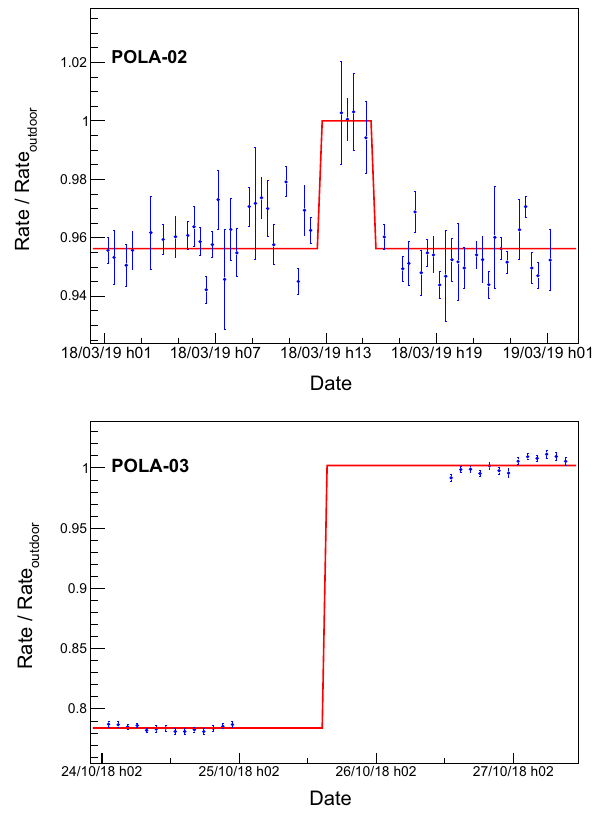
Fig. 4 Ratiosofthemeasuredrates,indoorandoutdoor,forthePOLA- 02 (upper panel) and POLA-03 (lower panel) detectors